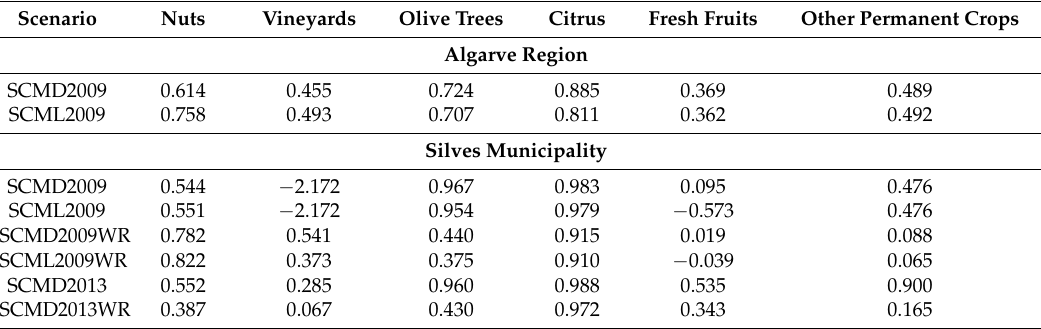
Table 5. The efficiency indicator in the Algarve region and Silves